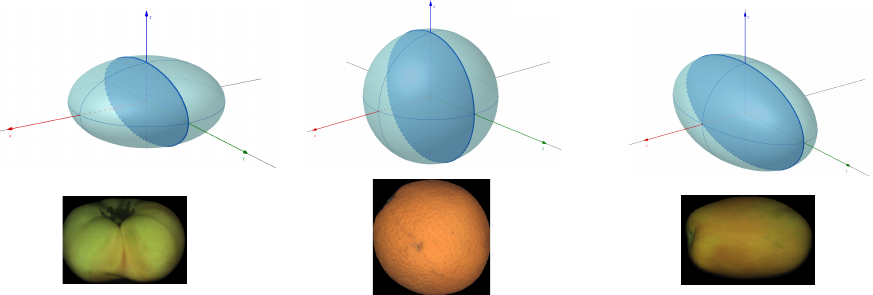
Figure 3. Fruit geometry models and examples. From left to right: oblate, spherical, and prolate models. The outcome of this method (that will be used as input to create the map)